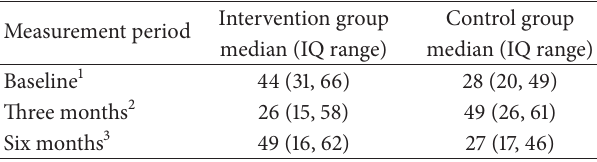
Table 4: Fatigue score at baseline and three and six months in relation to a 10-week physical activity